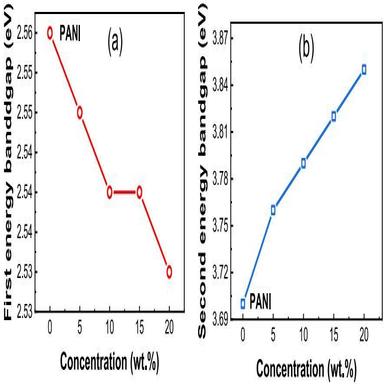
Variation of the first energy bandgap (a) and the second energy bandgap (b) as a function with concentration for the PANI and PANI-Al2O3 nanocomposite films.